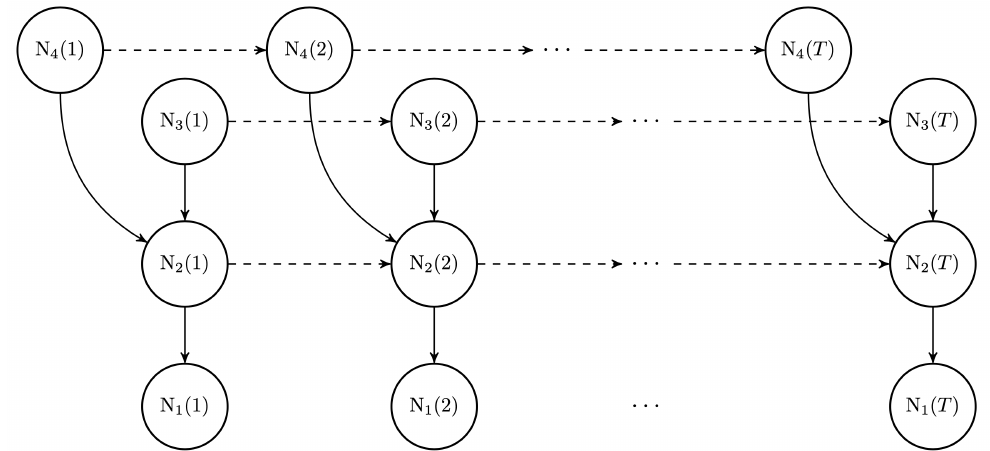
Figure 6. Diesel fuel SCN for NSA Monterey. The military installation (N 1 ) is preceded by a bulk terminal (N 2 ), which in turn receives stock from two refineries (N 3 and N 4 ). The solid arcs correspond to conditional relationships between parent and child nodes. Dashed arcs denote discrete state transitions from t − 1 to t